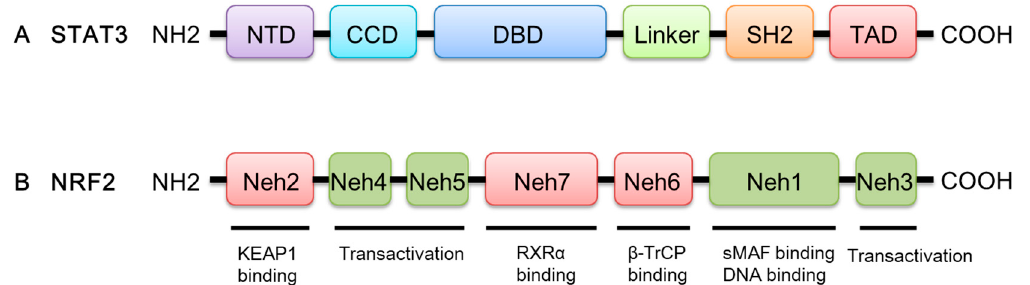
Figure 1. A schematic diagram of the domain structures of STAT3 and NRF2. ( A ) STAT3 has six functional domains, including NTD, CCD, DBD, Linker, SH2, and TAD. ( B ) NRF2 has seven conserved domains labeled Neh1–Neh7.